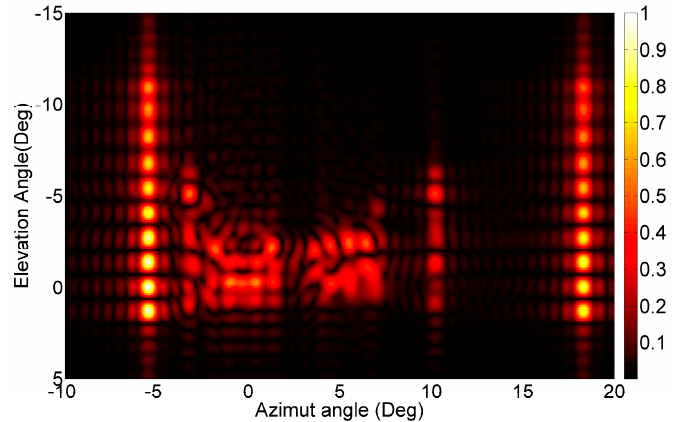
Figure 7. The 2D focusing result for the real scenario, with focusing distance equal to 10 m.